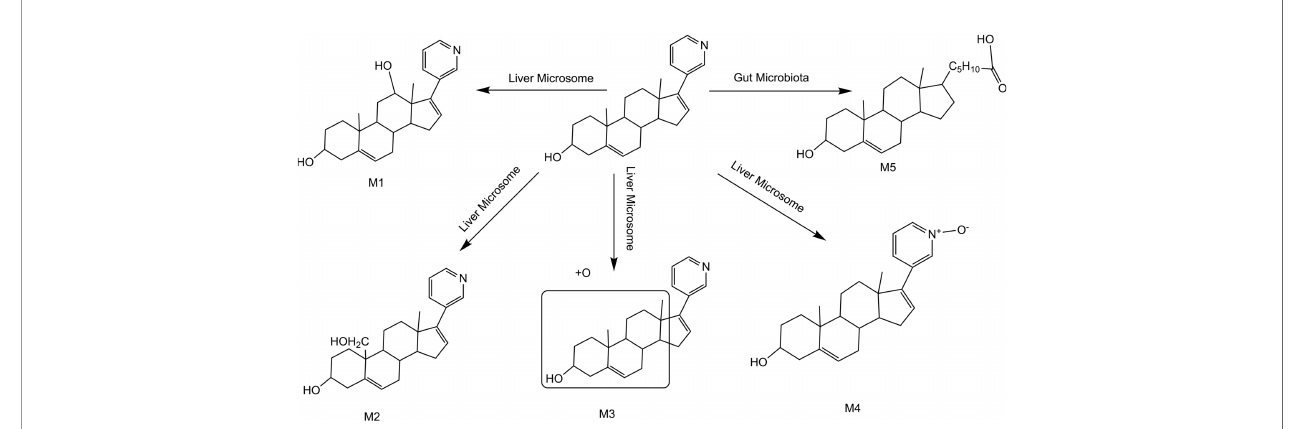
FIGURE 7 | Metabolic pathway of abiraterone in the gut microbiota system and liver microsomes (Abiraterone is metabolized in the gut microbiota to produce M5 and produce M1-4 in